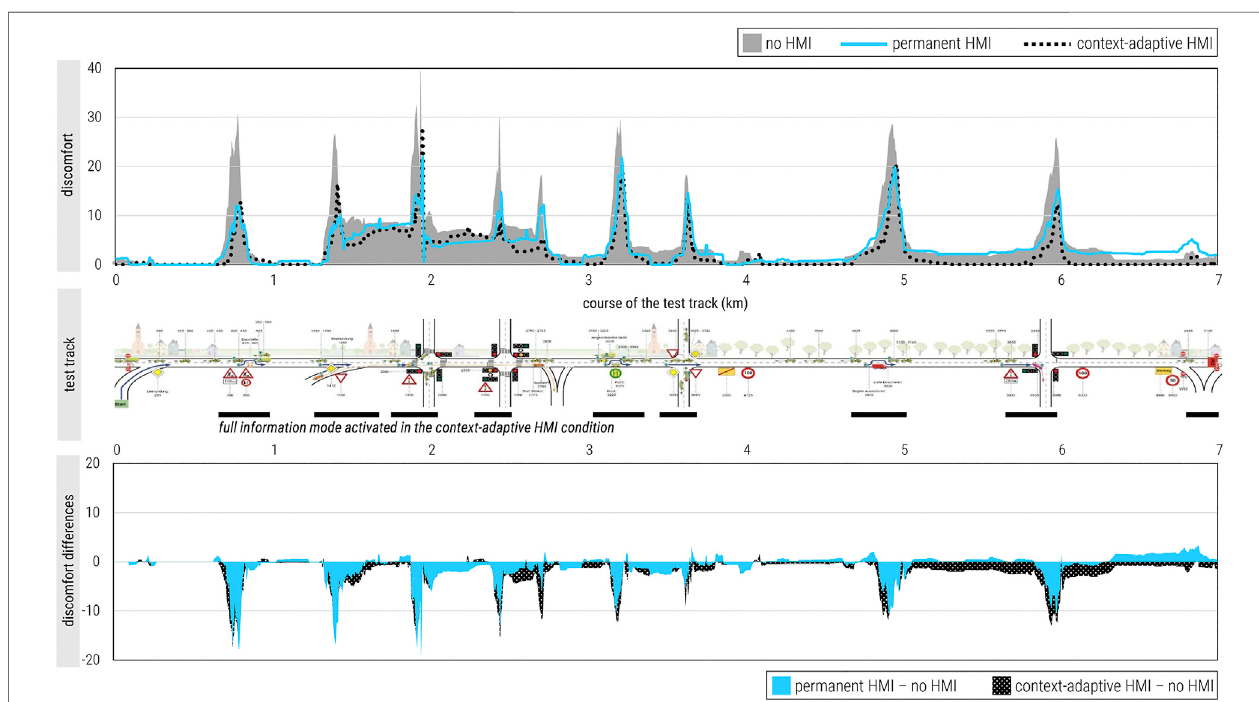
FIGURE3| Discomfortindicatedviahandsetcontrolduringdrivingalongthetesttrack,separatedbyHMIcondition. Note. Higherhandsetcontrolvaluesrepresent amoreuncomfortablepassengerexperienceindicatedduringdriving(onascalefrom0to100).Negativediscomfortdifferencesrepresentanimprovementofpassenger experience due to the respective HMI; positive values indicate a